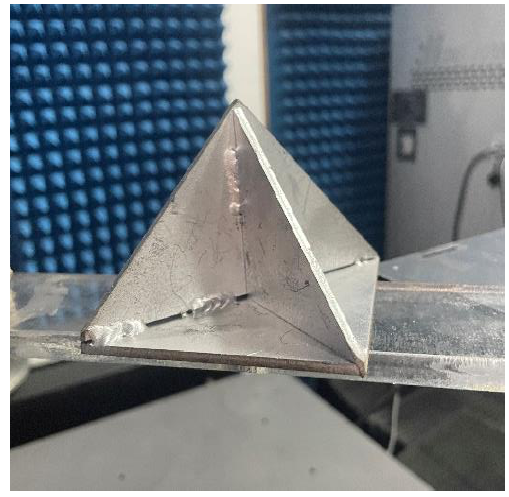
Figure 6. The optical image of the corner reflector.